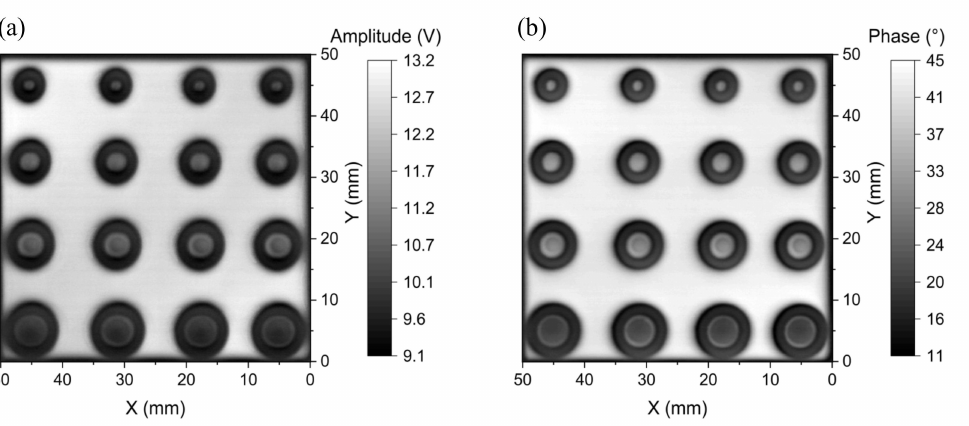
Figure 21. 2D images of ( a ) amplitude and ( b ) phase at the 60 kHz excitation frequency for the surface flaws on the two-layer PCB.